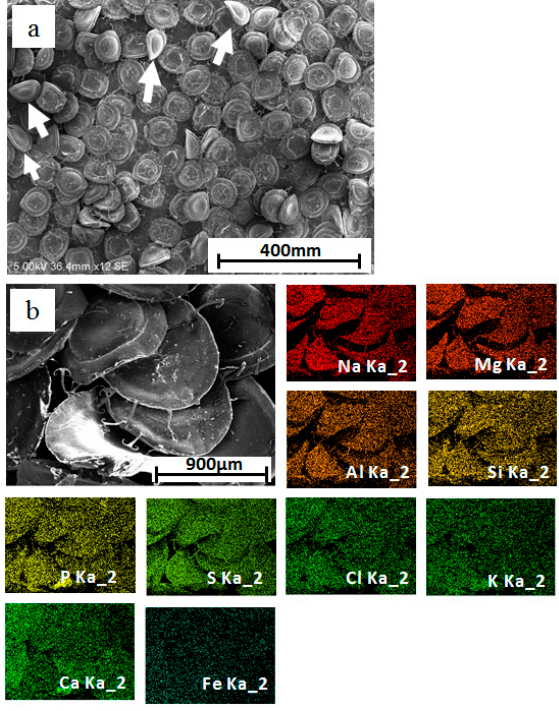
Figure 4. SEM micrographs of gathered statoblasts of Pectinatella magnifica ( a ) and the enlarged elemental distribution maps ( b ). The samples were collected from Makiyama agricultural reservoir Pond.